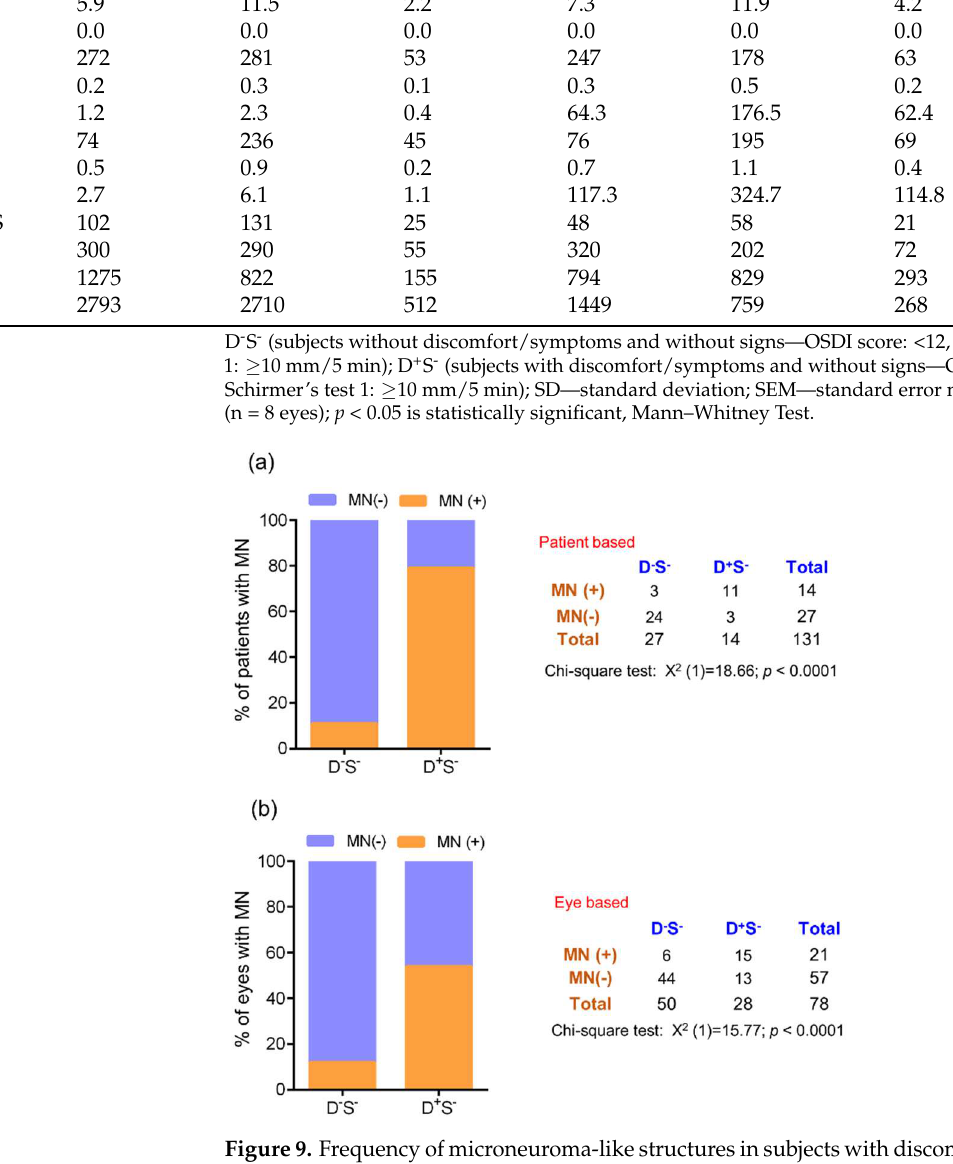
Figure 9. Frequency of microneuroma-like structures in subjects with discomfort but no signs. Stacked bar graphs represent ( a ) percentage of patients with and without microneuroma-like structures determined in laser scanning in vivo confocal microscopy images in the different groups. The adjacent table provides the absolute number of patients with and without microneuroma-like structures in the different groups. ( b ) percentage of eyes with and without microneuroma-like structures determined in laser scanning in vivo confocal microscopy images in the different groups. The adjacent table provides the absolute number of eyes with and without microneuroma-like structures in the different groups. D - S - indicates subjects without discomfort/symptoms and signs and D + S - indicates subjects with discomfort/symptoms but no signs. Chi-square test was performed to determine the statistical significance of the difference in the frequency of microneuroma-like structures between the groups. p < 0.05 is considered to be statistically significant. MN—microneuroma-like structures. Table 1. Tear fluid secreted factors levels in subjects with discomfort but no signs. D - S -